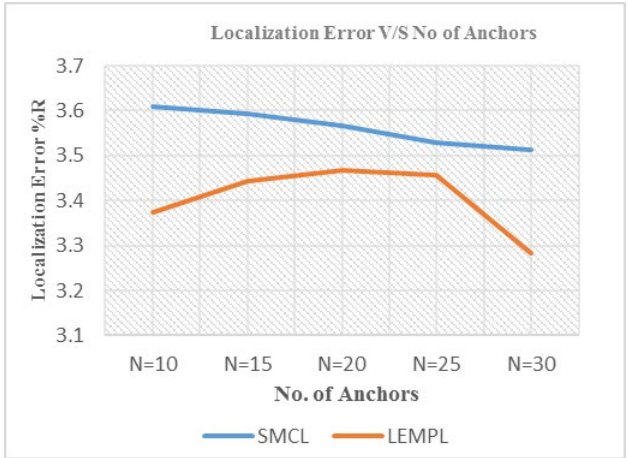
Figur e 3. Communication Cost (Mobile Nodes n=100, Anchor Nodes N=10)